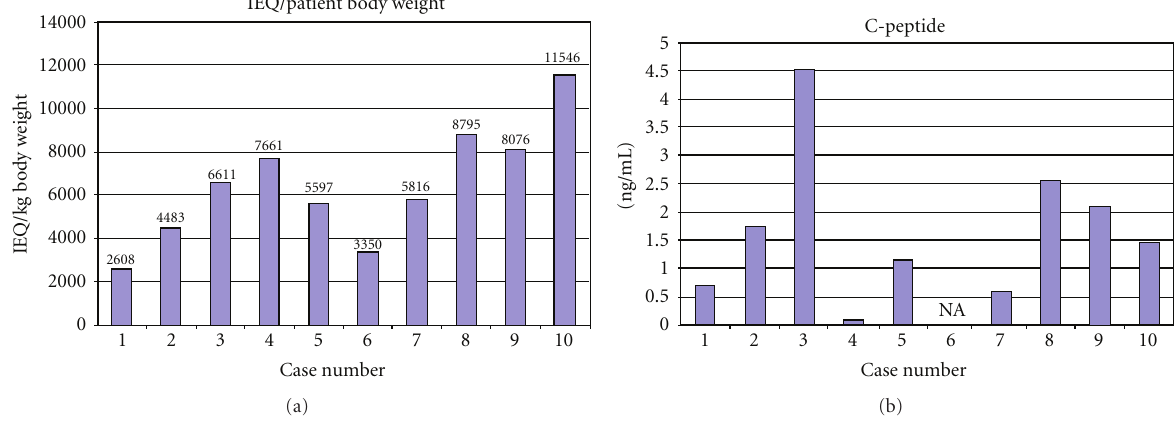
Figure 3: In (a) Islet yield expressed as islet equivalent (IEQ) numbers per kg of patient body weight. In (b) Serum C-peptide levels 6 months after transplant. Case no. 9: Serum C-peptide levels 3 months post-transplant. NA: not available.